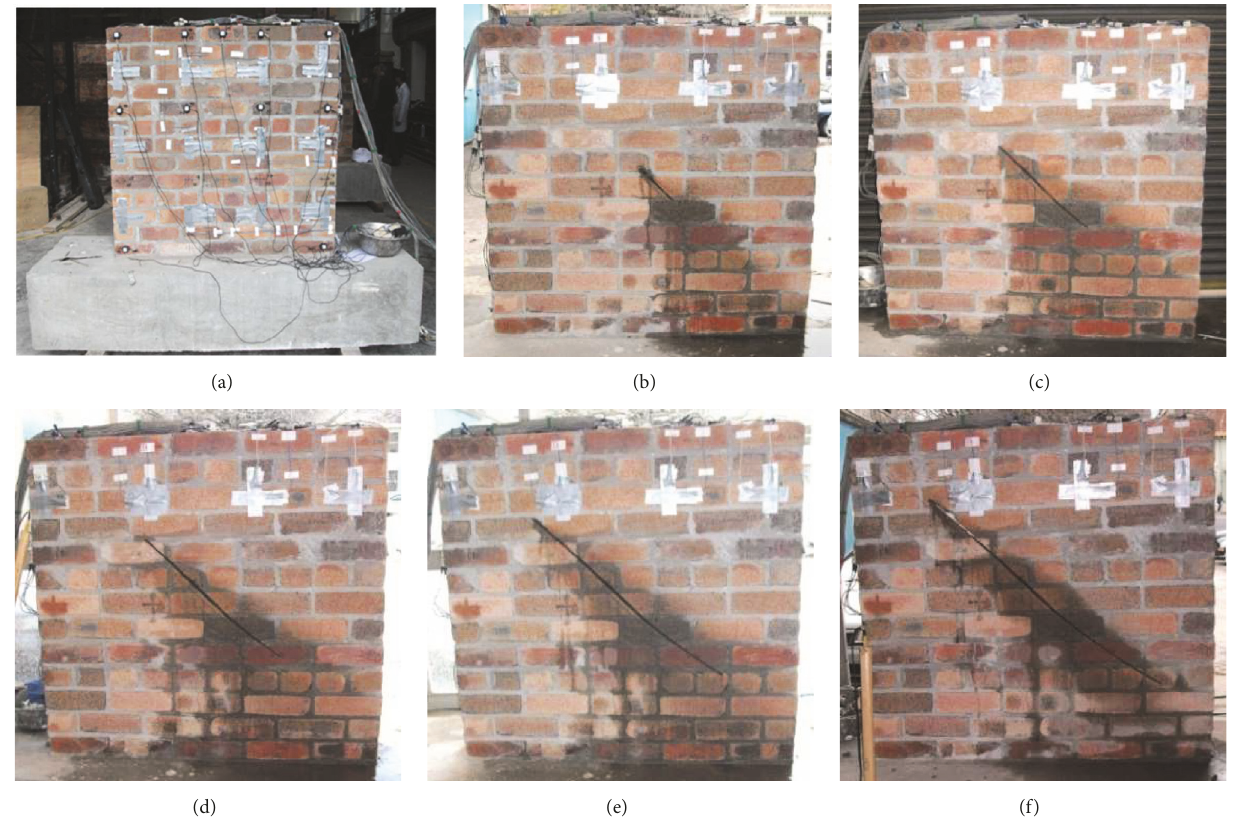
Figure 8: Specimen at different damage states. (a) DS0, (b) DS1, (c) DS2, (d) DS3, (e) DS4, and (f) DS5.